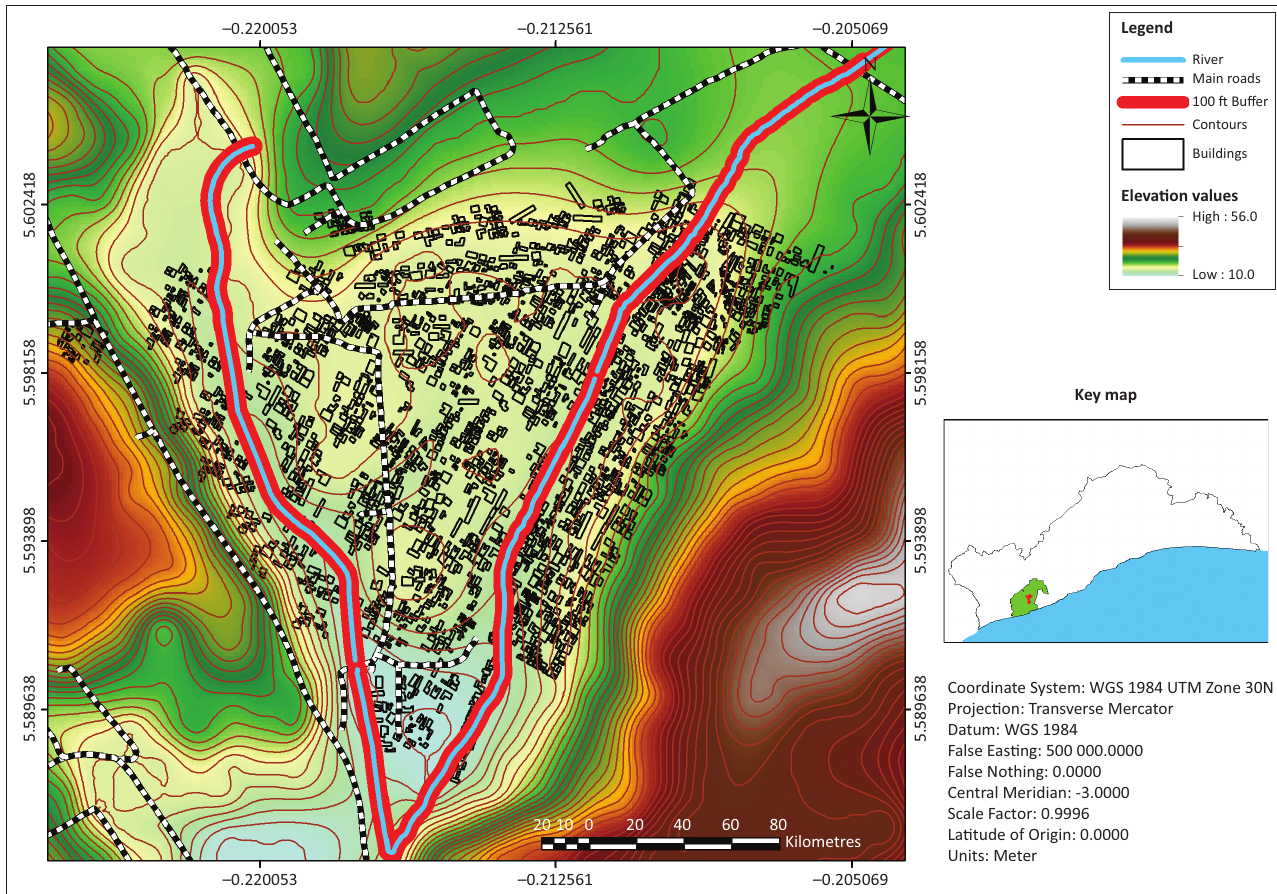
FIGURE 4: Map of Alajo showing areas of flood